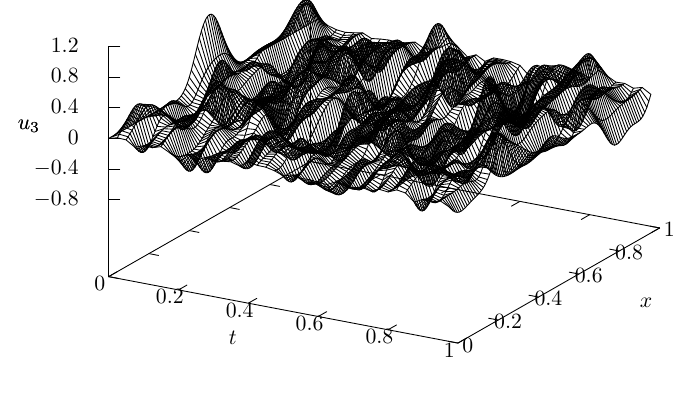
Figure 9. The numerical solution to the elastic in Equation (97), which is connected at x = 0.8 to a mass-spring system in Equation